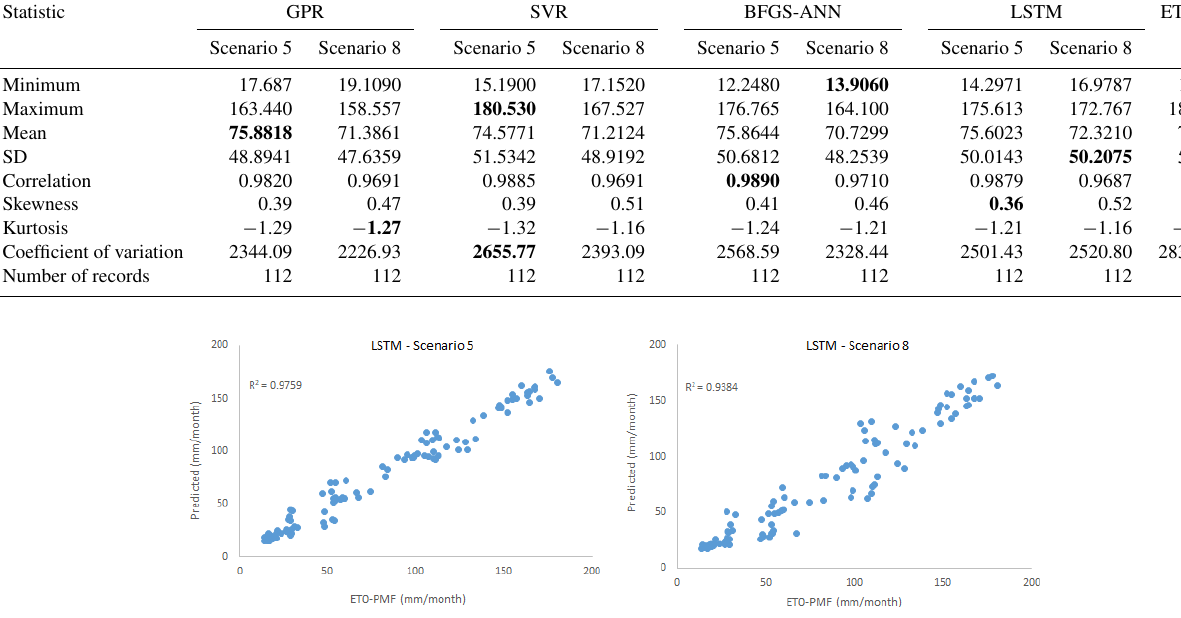
Table 8. Statistical values of the test phase for selected scenarios (the best/closest results are in bold). Statistic